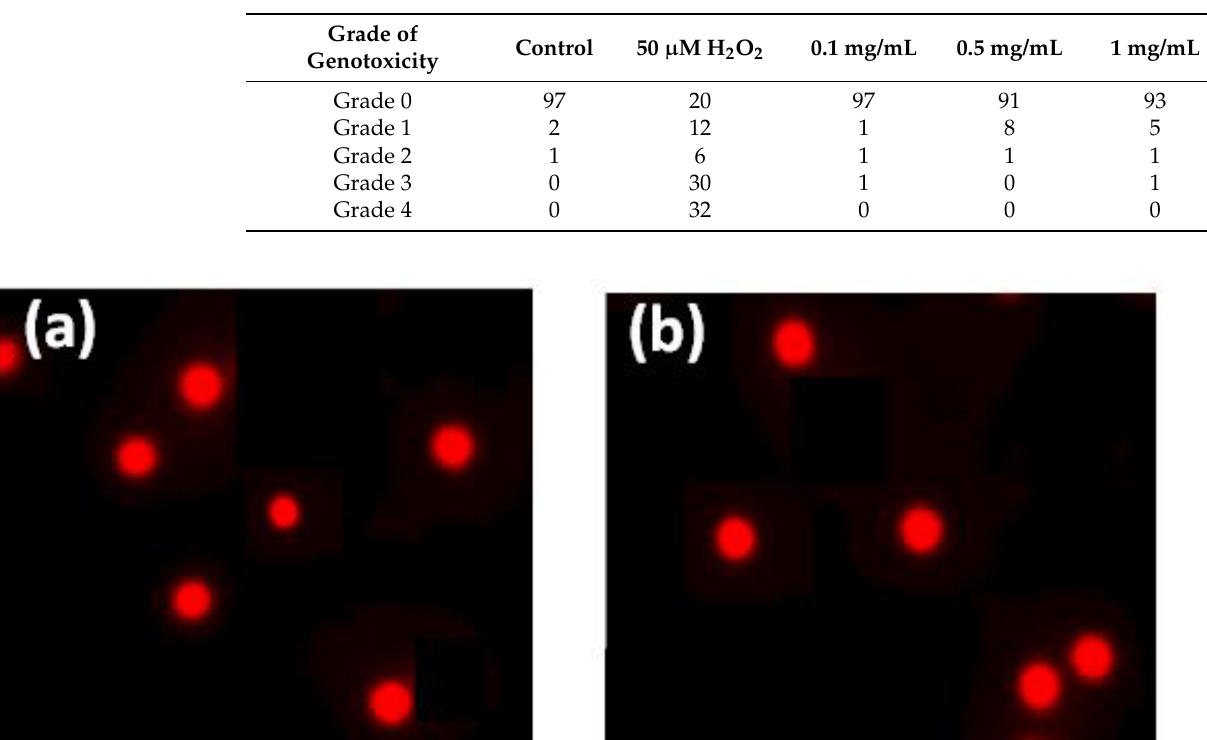
Table 5. Effect of PEG-GMO20 formulation on DNA damage in HaCaT cells estimated with the comet assay.